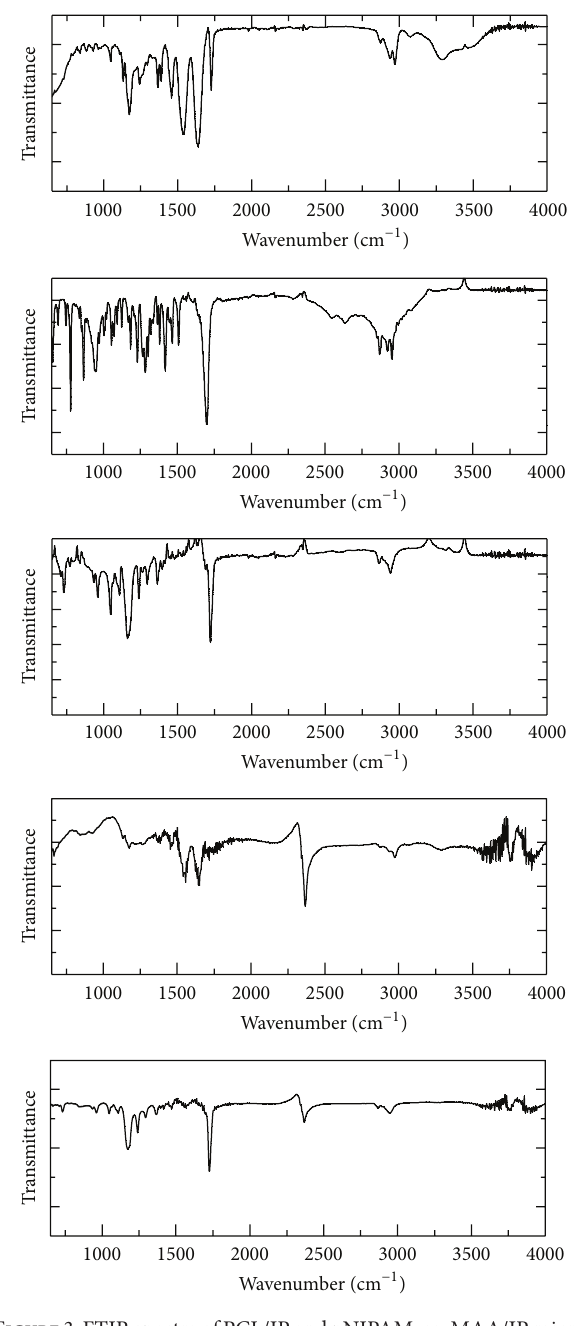
Figure3:FTIRspectraofPCL/IPandpNIPAM-co-MAA/IPmicro- fibers (MFs), as well as spectra of PCL, pNIPAM-co-MAA, and IP for comparison.